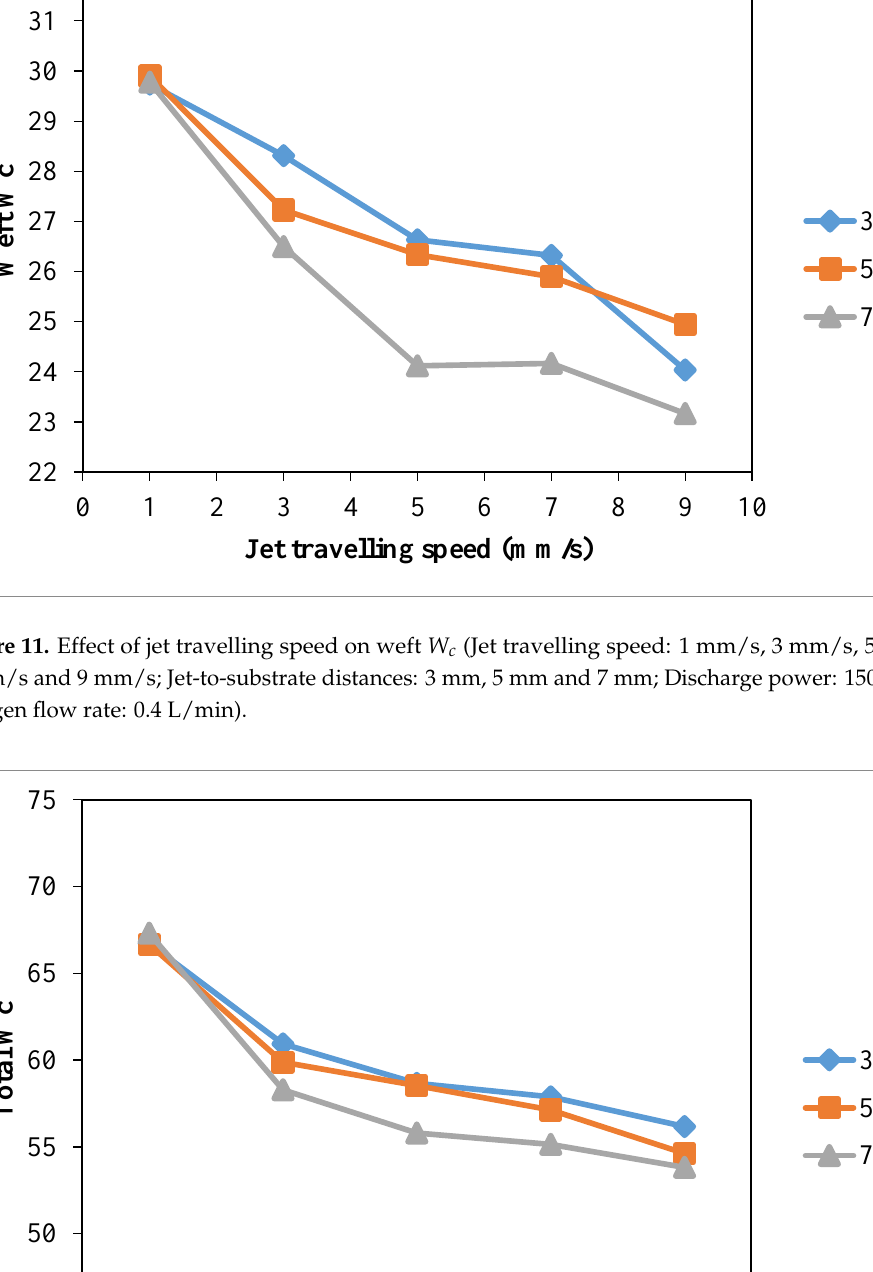
Figure 10. Effect of jet travelling speed on warp W c (Jet travelling speed: 1 mm/s, 3 mm/s, 5 mm/s, 7 mm/s and 9 mm/s; Jet-to-substrate distances: 3 mm, 5 mm and 7 mm; Discharge power: 150 W and Oxygen flow rate: 0.4 L/min).